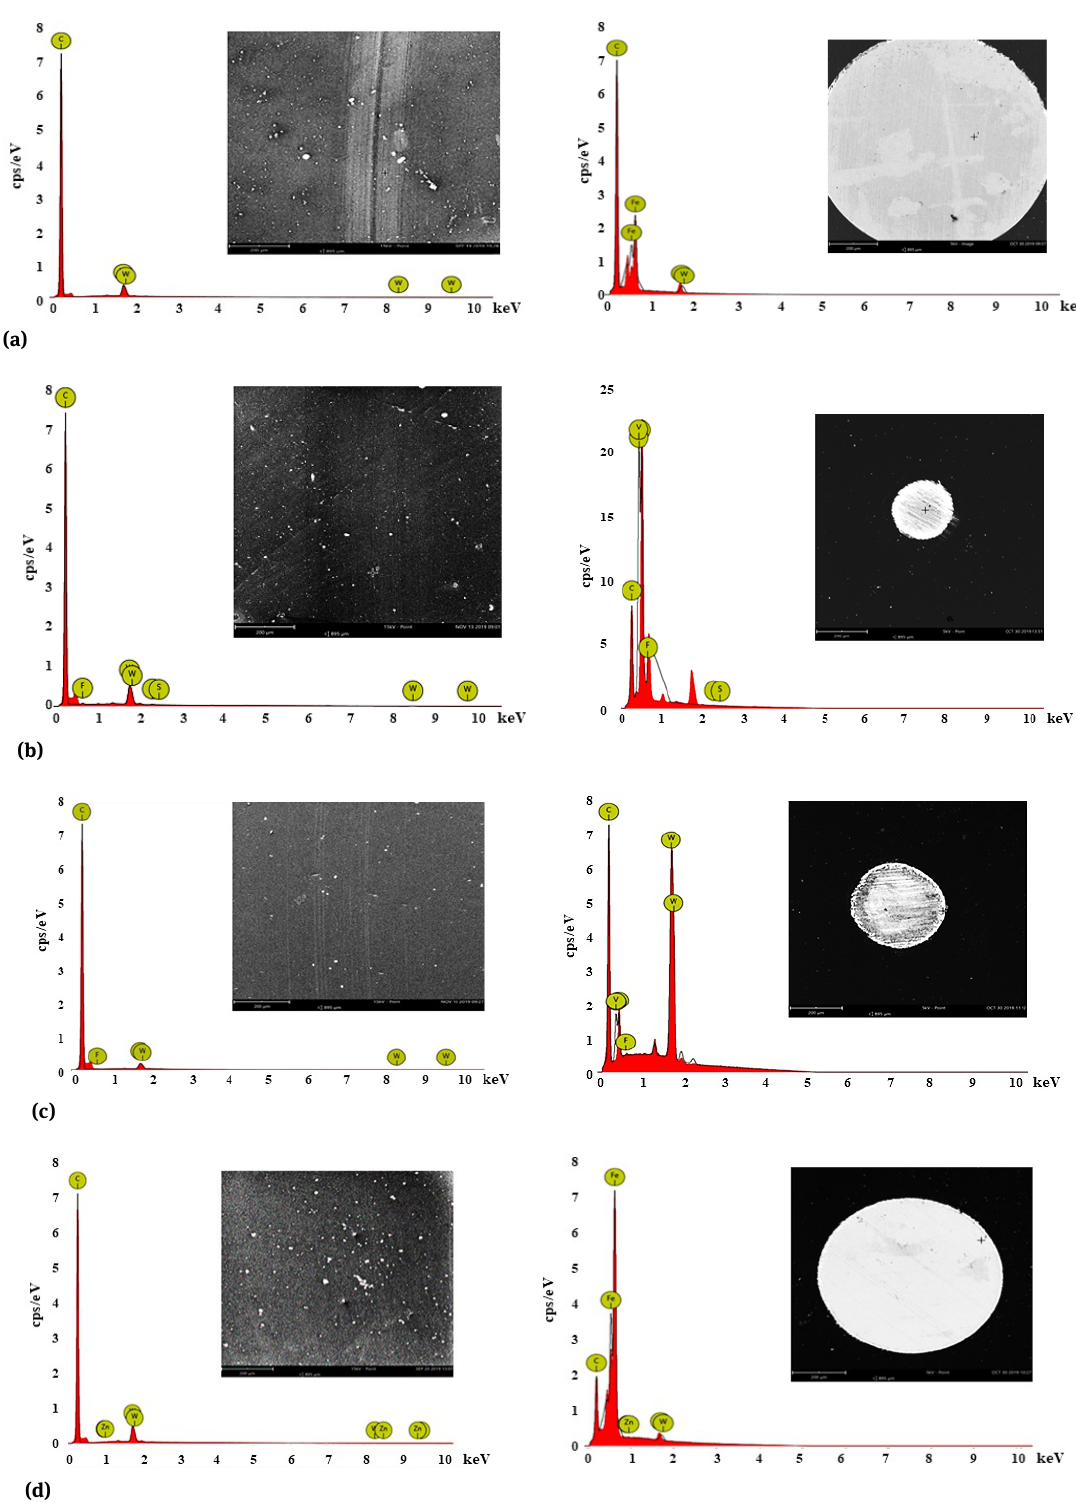
Figure 8: View of the wear trace of the disc and ball and point analysis of the elements after frictional cooperation in the following condi- tions: a) TDF, b) IL1 lubrication, c) IL2 lubrication, d) BCCS